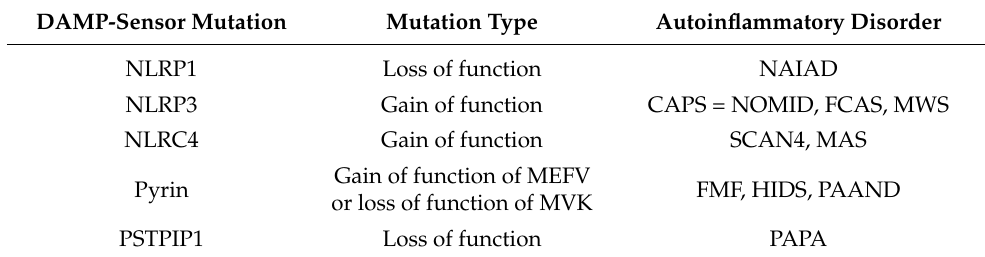
Table 2. DAMP-sensor-associated genetic disorders. DAMP-Sensor Mutation Mutation Type